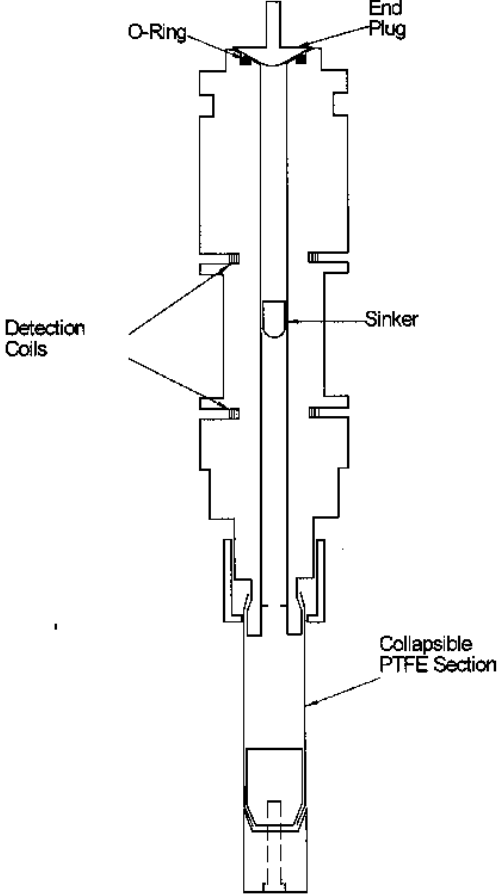
Figure 1. Falling body